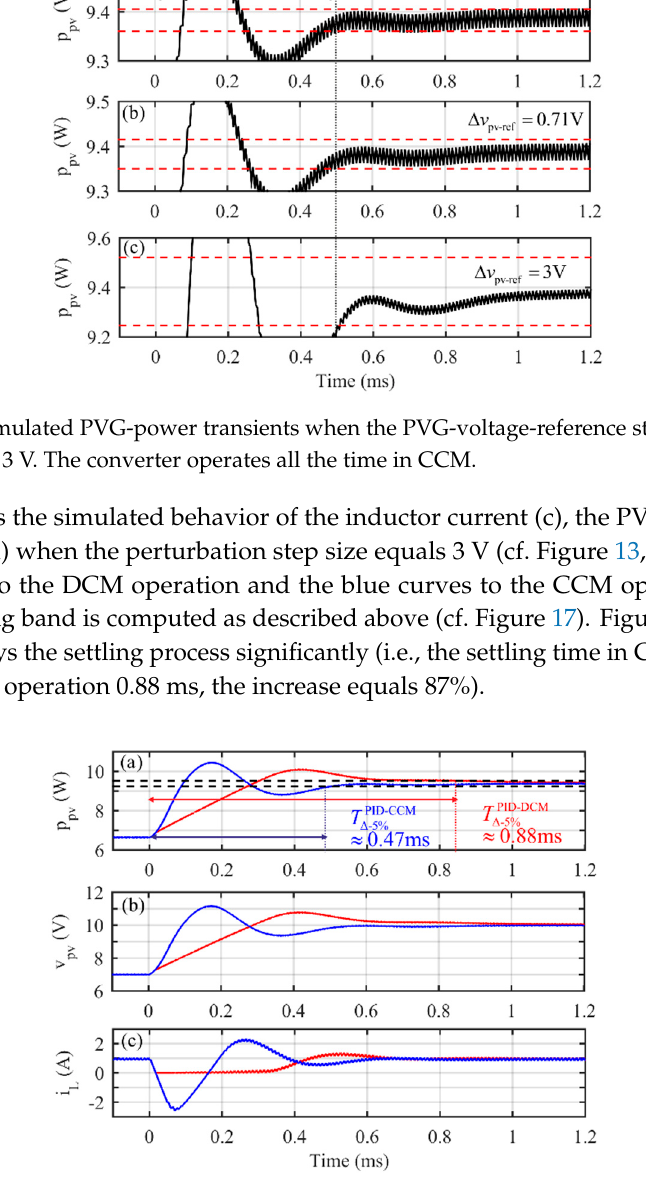
Figure 18. The simulated PVG power ( a ), PVG voltage ( b ), and inductor-current ( c ) transients when the PVG-voltage-reference step size is 3 V. The red curves correspond to the situation, where the interfacing converter enters into DCM. The blue curves correspond to the situation, where the interfacing converter operates all the time in CCM.